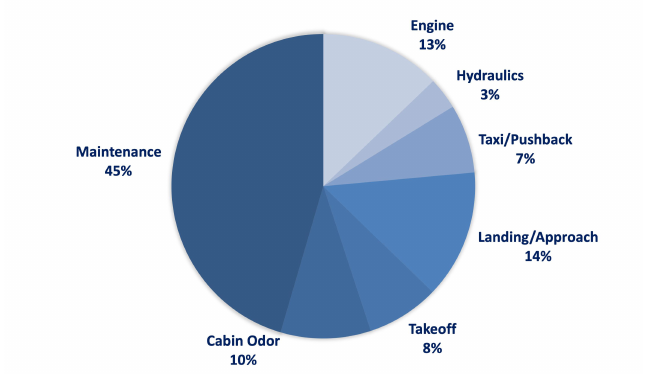
Figure 4. Proportion of Reports in the 7 Main Clusters.